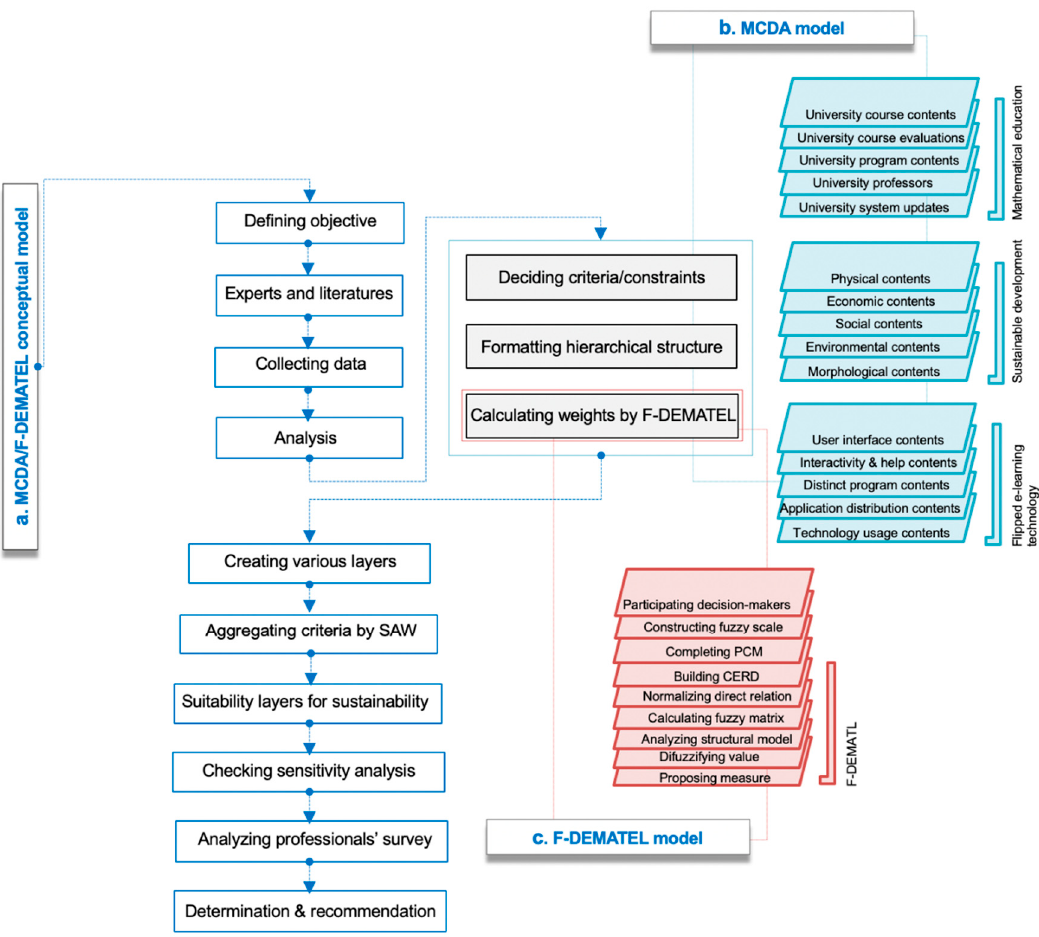
Figure 1. Multi-criteria decision analysis / fuzzy-decision-making trial and evaluation laboratory (MCDA / F-DEMATEL) conceptual model in three sections: ( a ) General conceptual model; ( b ) MCDA criteria and sub-criteria in selected model; and ( c ) the particular F-DEMATEL model.